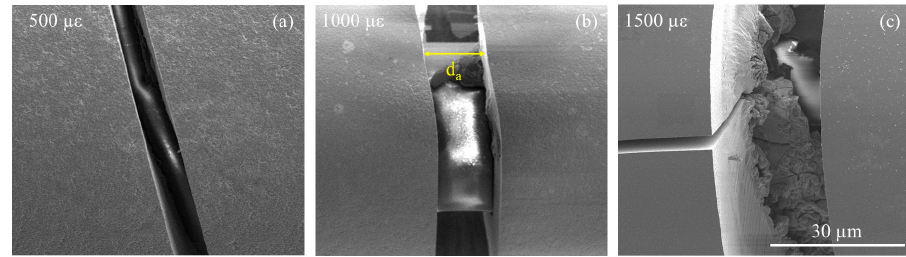
Figure 5. Transverse cracks on the Fe-C layer at ( a ) 500 µ ε , ( b ) 1000 µ ε , and ( c ) 1500 µ ε .